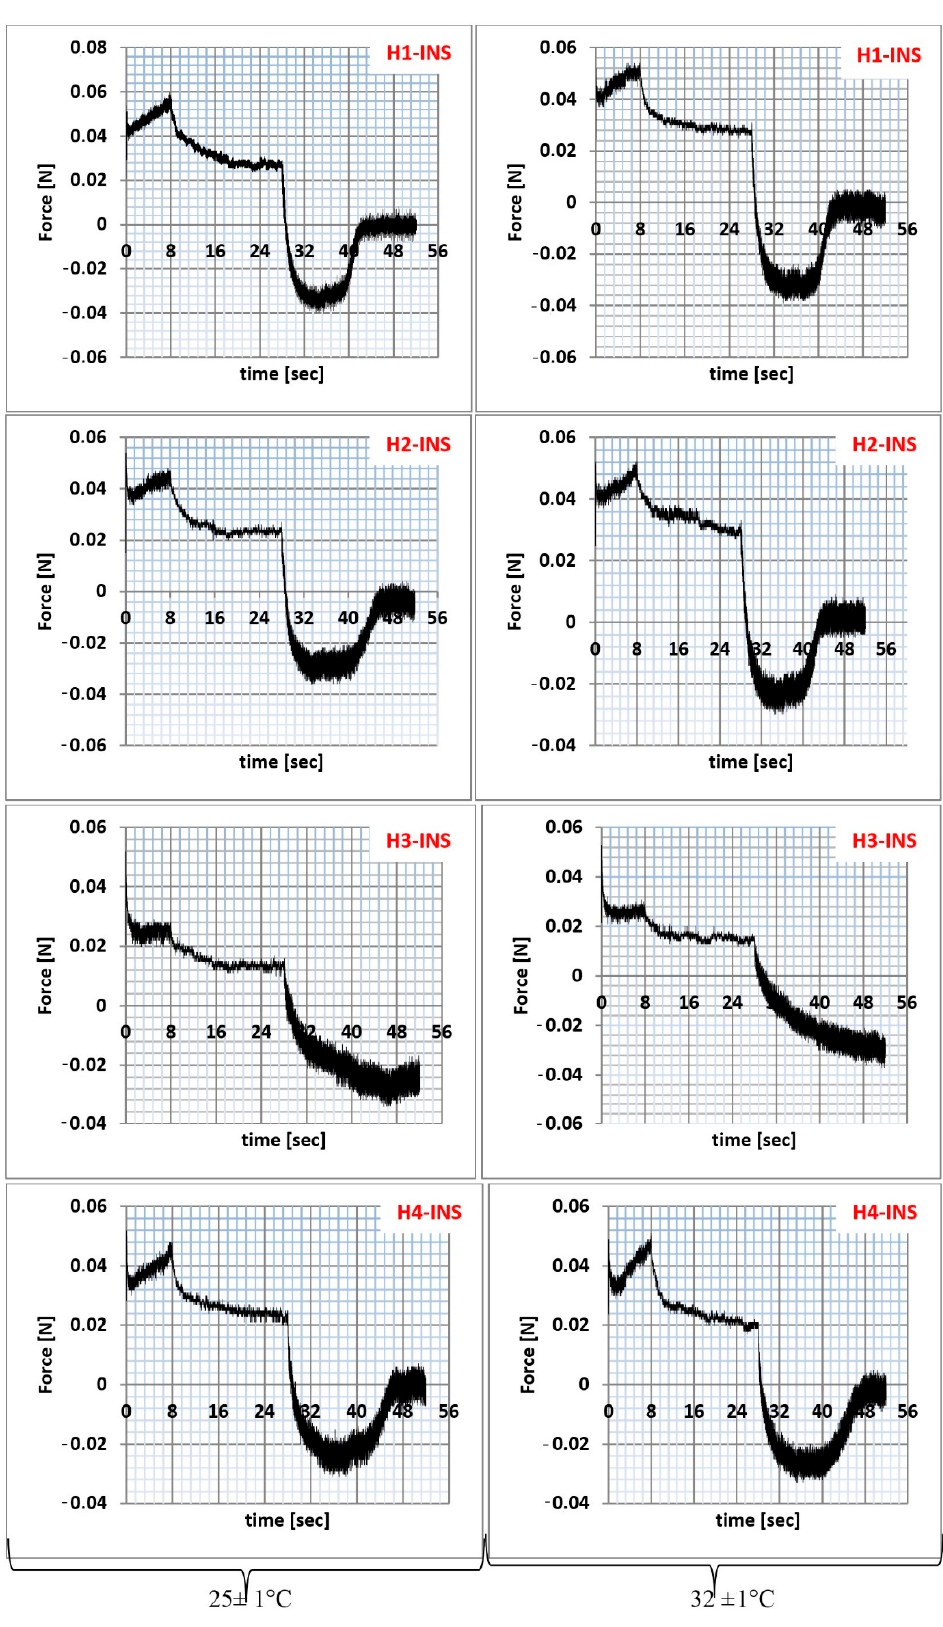
Figure 6. Compression/relaxation/tension (CRT) of hydrogel samples at 25 ± 1 °C and 32 ± 1 °C.